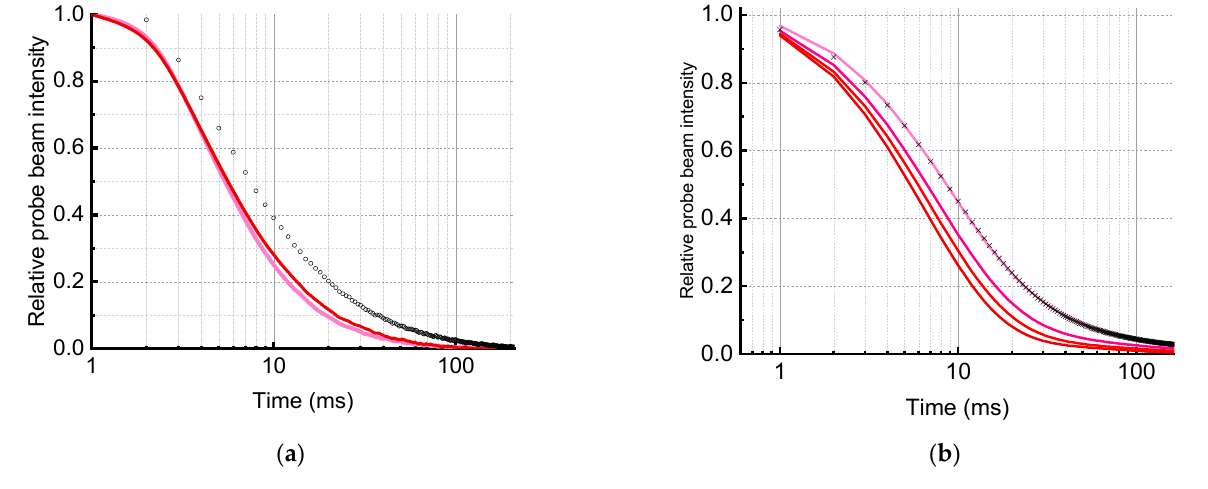
Figure 10. Normalized averaged transient thermal-lens curves for the heating stage. ( a ) For water, light blue symbols, and aqueous colloidal solutions of TM-50 silicon oxide (1.6 and 3.1% v / v , black and red lines, respectively). The higher the nanoparticle concentration, the faster the heating of the solution. ( b ) For aqueous dispersions of RUDDM nanodiamonds at concentrations of 1, 1.5, 2, and 2.5 mg/mL (light pink, pink, red, and burgundy lines, respectively) and for water (black symbols). Heating time, 4 s. Setup, TLS-60; excitation wavelength, 532.0 nm; excitation power, 20 mW. The higher the nanoparticle concentration, the faster the heating of the solution.